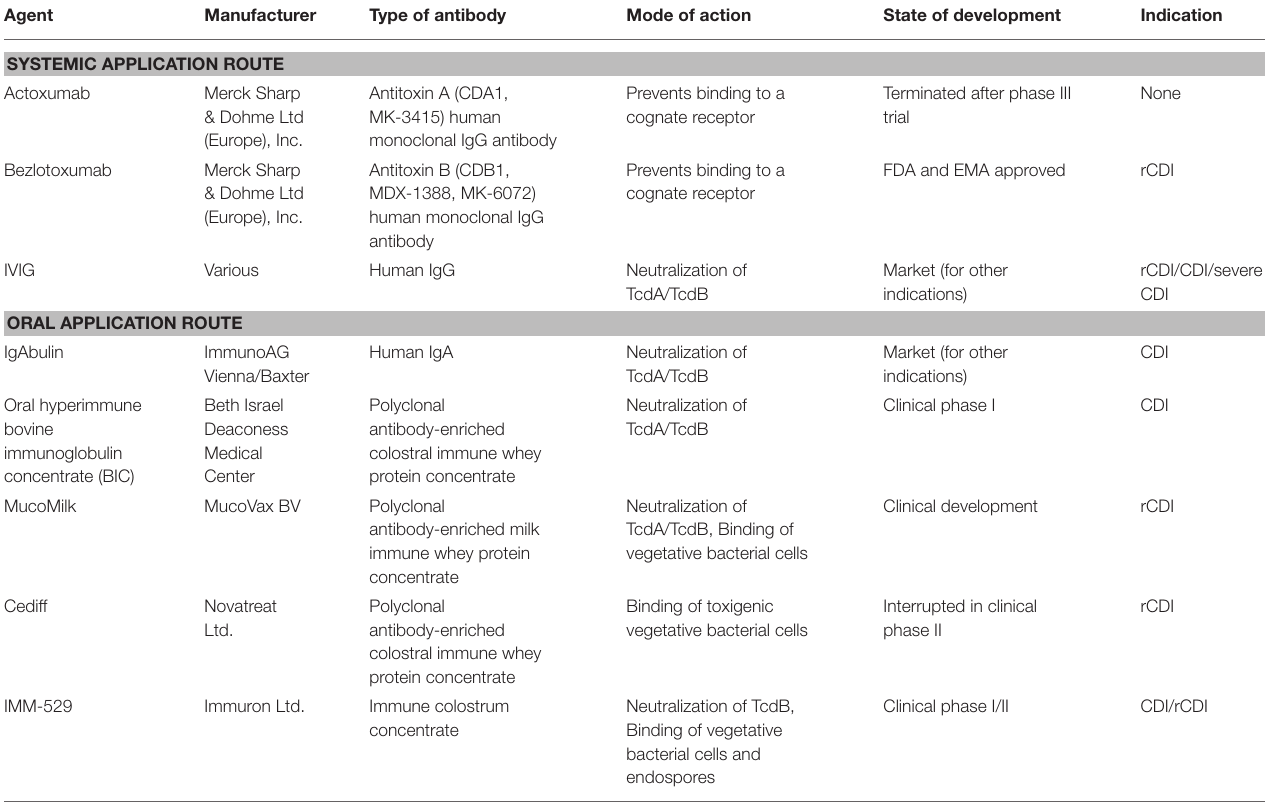
TABLE 1 | Clinically tested antibody-mediated therapeutic agents for CDI. Agent State of development